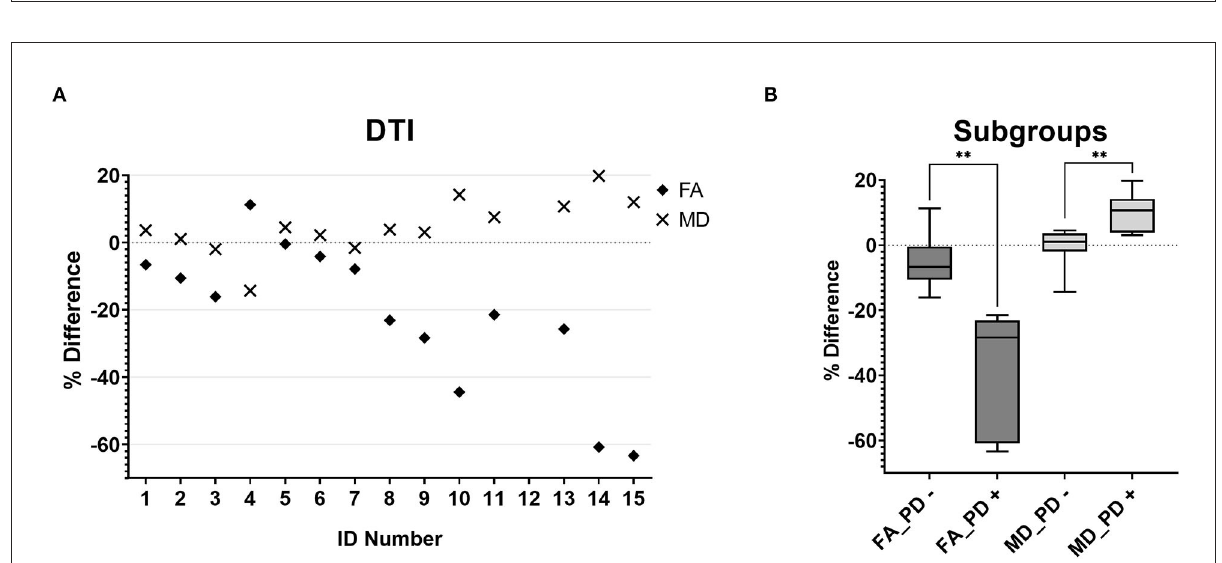
FIGURE3 MD (diamonds) and FA (crosses) percentage differences between the two anterior quadrants of the medulla oblongata for all individual patients (A) . The boxplots [ (B) , boxes extend from the 25th to 75th percentiles with a line indicating the median, whiskers indicate the minimum and maximum] demonstrate that patients who had conspicuous findings in the quantitative PD analysis showed significantly lower FA (FA_PD + , p = 0.006) and MD (MD_PD + , p = 0.002) values on the side where a HOD was to be expected than patients without conspicuous findings in the quantitative PD analysis (FA_PD-; MD_PD-). MD,mean diffusivity; FA, fractional anisotropy; PD, proton-density; HOD, hypertrophic olivary